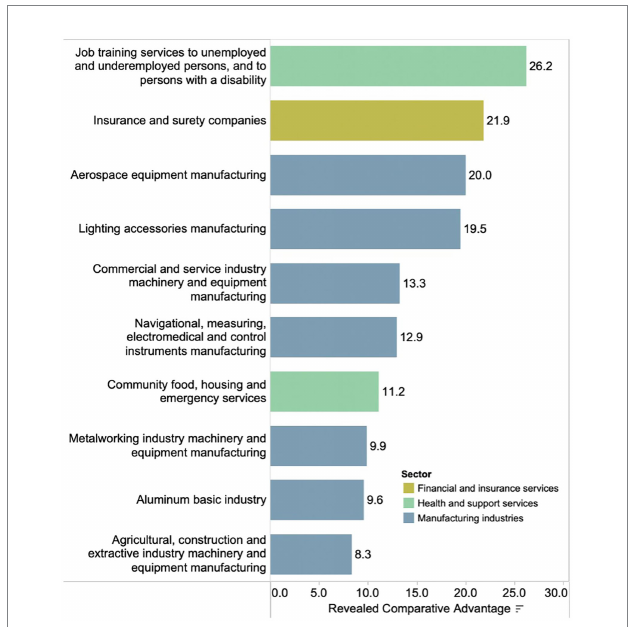
FIGURE 4 Industrial specialization of the MAQ. Own elaboration based on Economic Censuses 2019